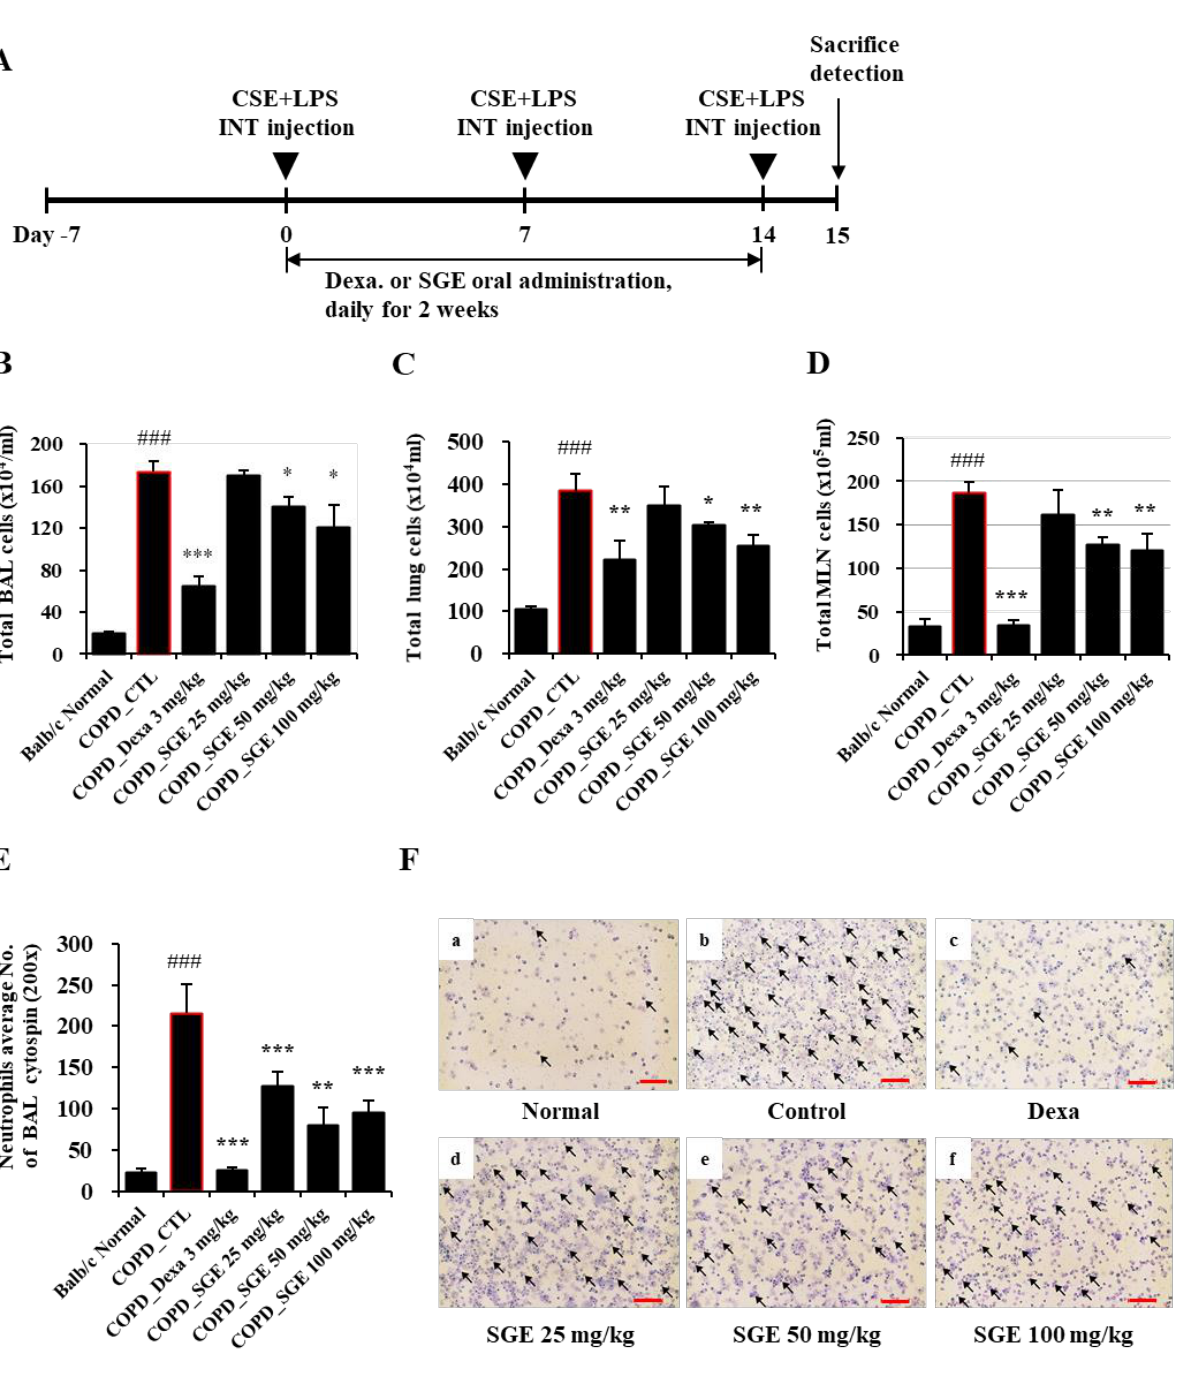
Figure 3. Effects of SGE on the number of airway immune cells and neutrophilic airway inflam- mation in CSE/LPS-induced COPD murine model. ( A ) Schematic diagram of CSE/LPS-induced COPD model in mice. ( B ) The total number of cells in COPD-induced BALF in each treatment group. ( C ) The total number of cells in the lungs of COPD-induced mice in each treatment group. ( D ) The total number of cells in COPD-induced MLN in each treatment group. ( E ) The number of neutrophils in BALF was counted using a hemocytometer. ( F ) Photomicrograph of BALF cytospins from COPD model mice treated with CSE/LPS (magnification, 200 × ) by differential leukocyte staining. Neutrophils are indicated by arrows. Scale bar = 100 µ m. The data are presented as means ± SEM (n = 6 mice) for individual mice. ### p < 0.001 compared to normal, and * p < 0.05, ** p < 0.01, and *** p < 0.001 compared to control. Dexa,